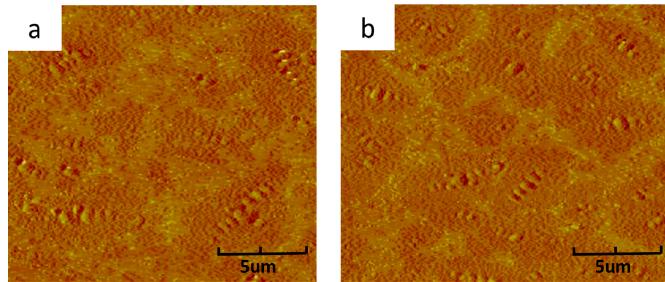
Figure 5. AFM images of regenerated TFOT aged bitumen: ( a ) regenerated TFOT aged bitumen with 10 wt % CR, ( b ) regenerated TFOT aged bitumen with 10 wt % SR.